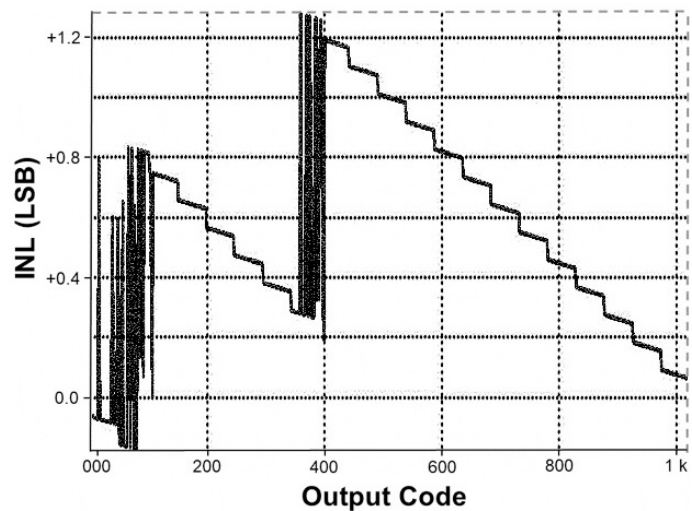
Figure 18. Measured INLs of the proposed SAR ADC.